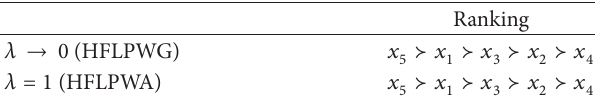
Table 4: Rankings of the alternatives.